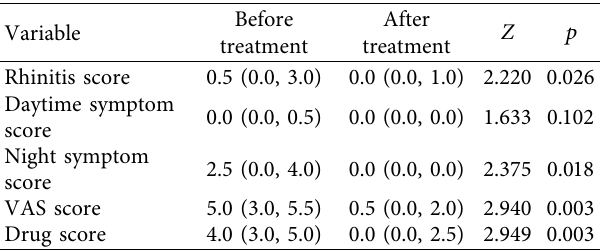
Table 4: Comparison of scores of the single allergy group before and after